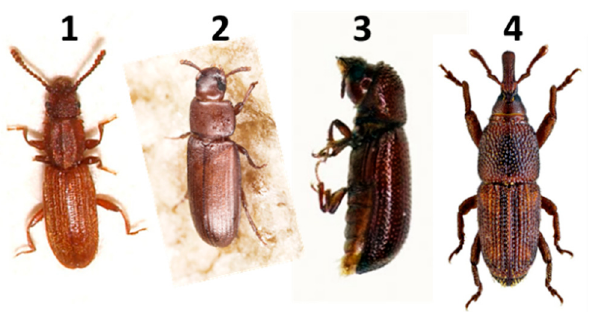
Figure 4. Four stored products used in current study ( 1 ) O. surinamenisis , ( 2 ) T. castaneum, ( 3 ) R. dominica, and ( 4 ) S. oryzae.